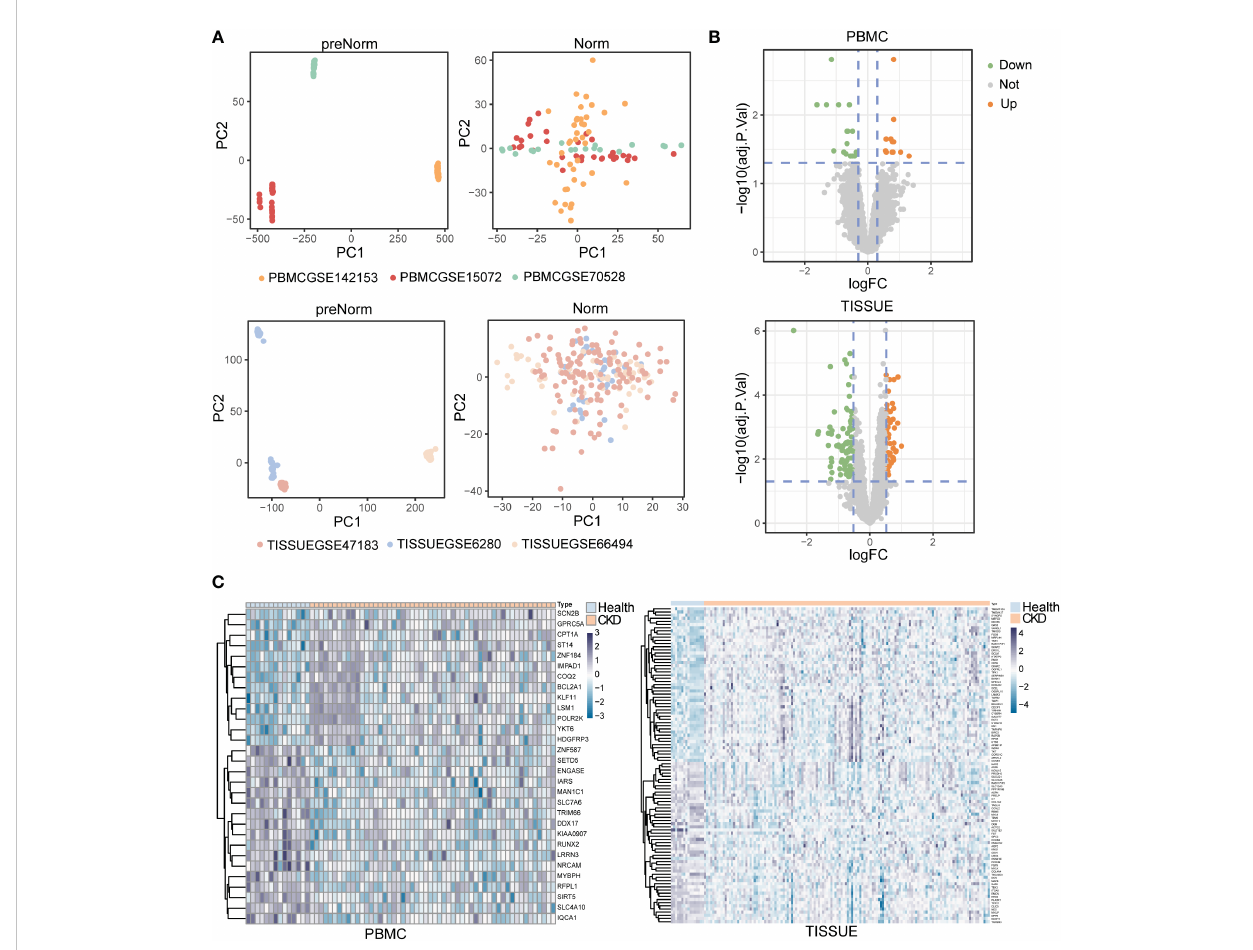
FIGURE 2 Identi fi cation of differentially expressed genes (DEGs) in peripheral blood mononuclear cell (PBMC) and TISSUE samples (A) Principal component analysis (PCA) of the GSM datasets. The samples were visualized by scatter plots based on two principal components (PC1 and PC2) of gene expression pro fi les without (left) or with (right) batch effect removal. Top, PBMC; bottom, TISSUE. (B) Volcano plots of the DEGs. The orange dots meant signi fi cantly upregulated genes, and the green dots represented signi fi cantly downregulated genes. The grey dots represented non- signi fi cantly changed genes. Top, PBMC; bottom, TISSUE. (C) Heatmap showing DEGs in different samples. Left PBMC, Right